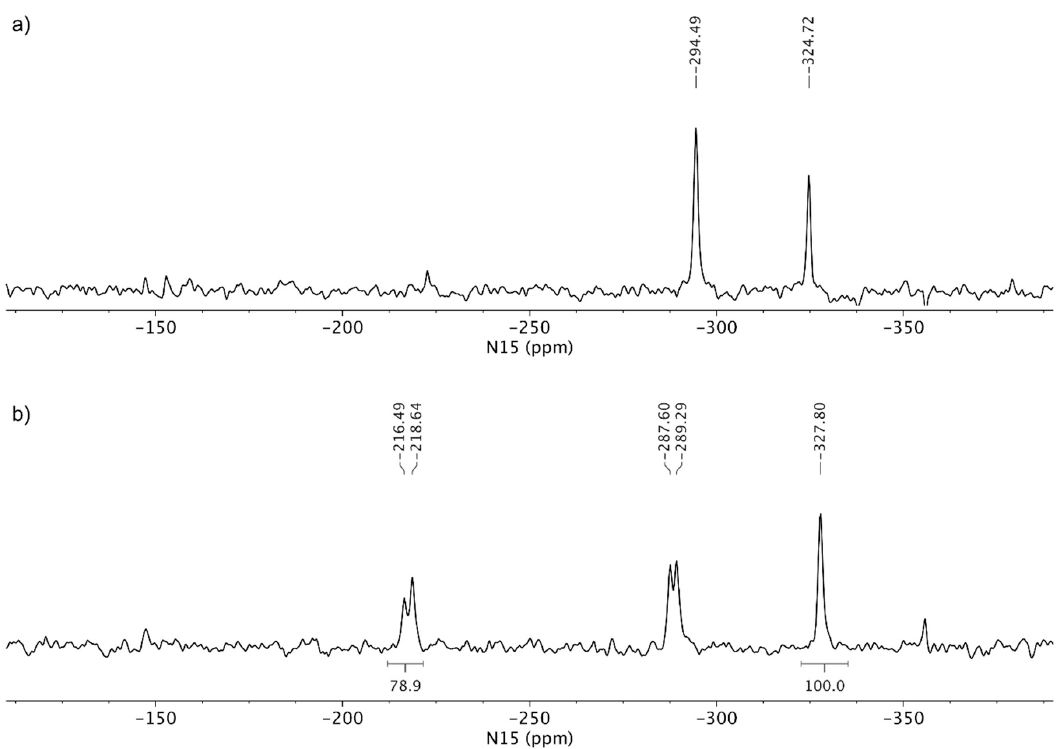
Figure 7. 15 N LG-CP MAS NMR (Lee-Goldburg cross-polarization magic angle spinning nuclear magnetic resonance) spectra of ( a ) TA and ( b ) TA HCl. Both spectra were acquired using a relaxation delay of 2 s and ca. 40,000 scans. The relative integral value of protonated purine nitrogen is reported with respect to the integral region of amine nitrogen, which was arbitrarily set at 100. 15 N LG-CP MAS NMR spectra of the tenofovir alafenamide monofumarate samples TA MF1 and